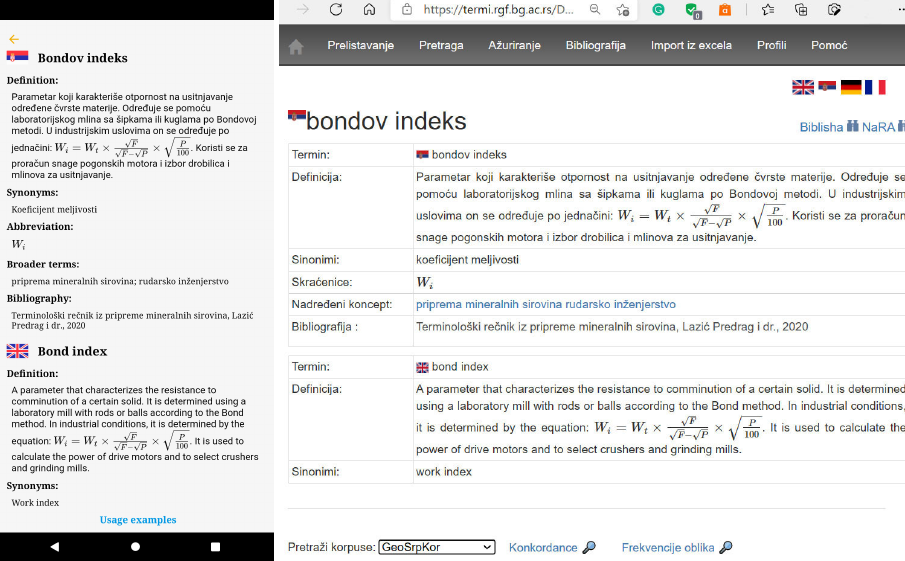
Figure 7. The mobile and Termi web application data entry preview for term